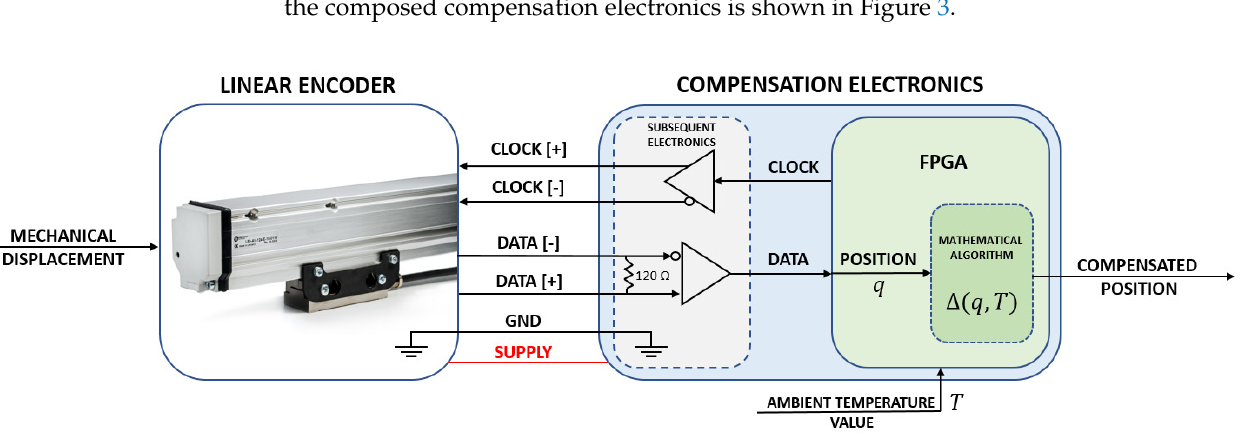
Figure 3. Block diagram of the compensation electronics with a field-programmable gate array (FPGA). The encoder readings, compensated encoder position values, and respective